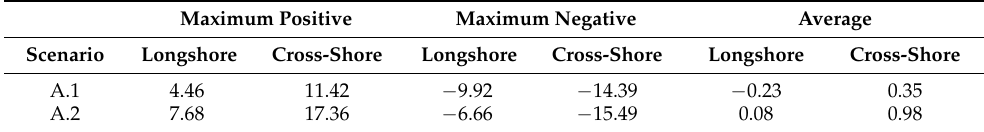
Table 2. Suspended sediment transport rates